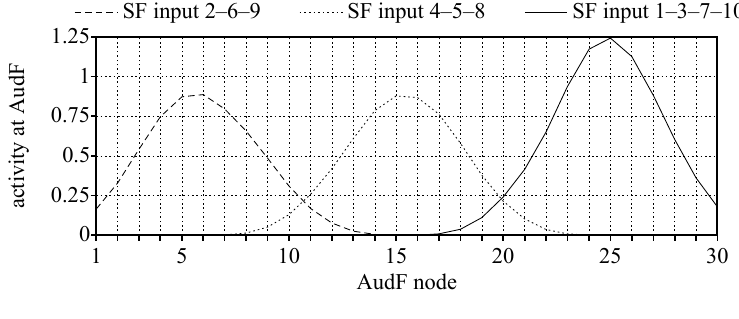
Figure 19: The activity at AudF, as a function of a